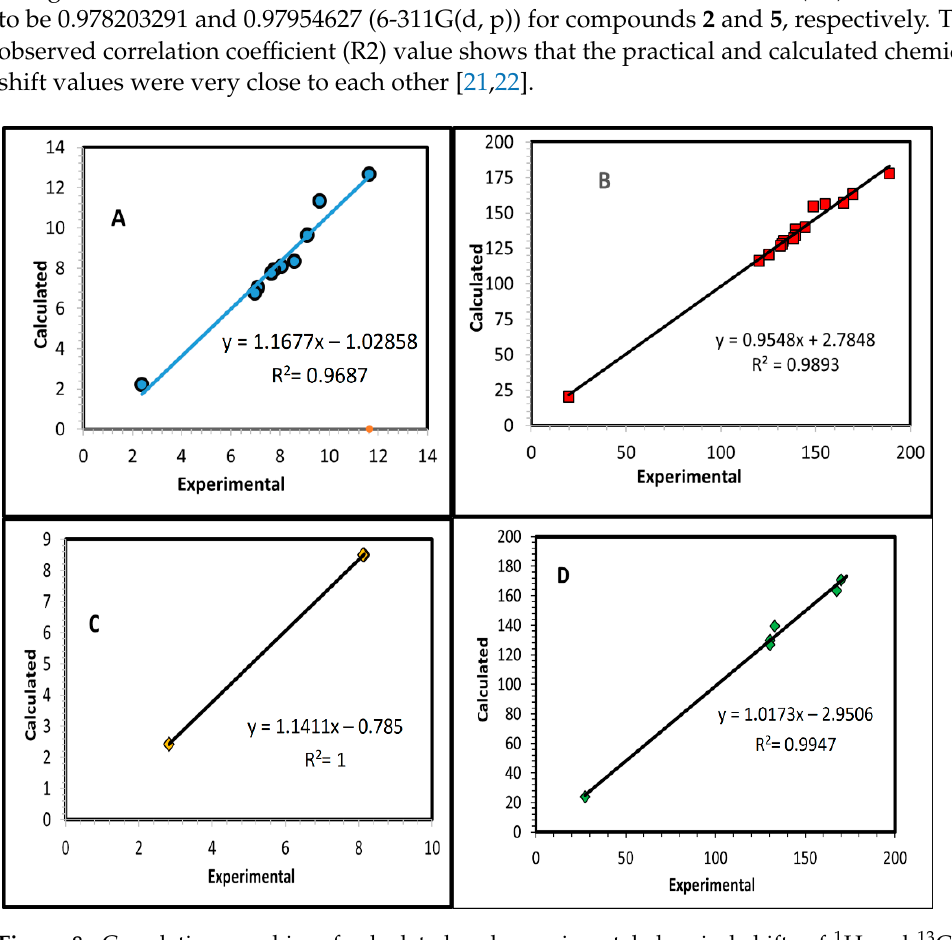
Figure 8. Correlation graphics of calculated and experimental chemical shifts of 1 H and 13 C of compound 5 in ( A , B ), respectively, as well as 1 H and 13 C of compound 2 in ( C , D ), respectively.